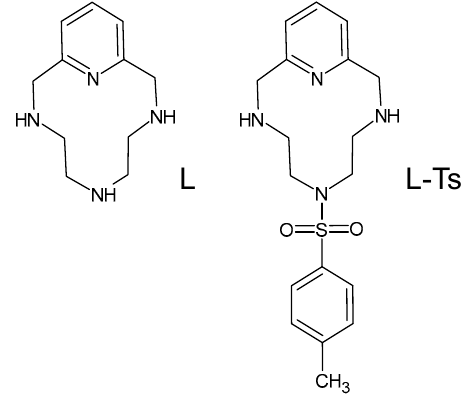
Figure 1. Ligand L and its tosylated derivative L-Ts.